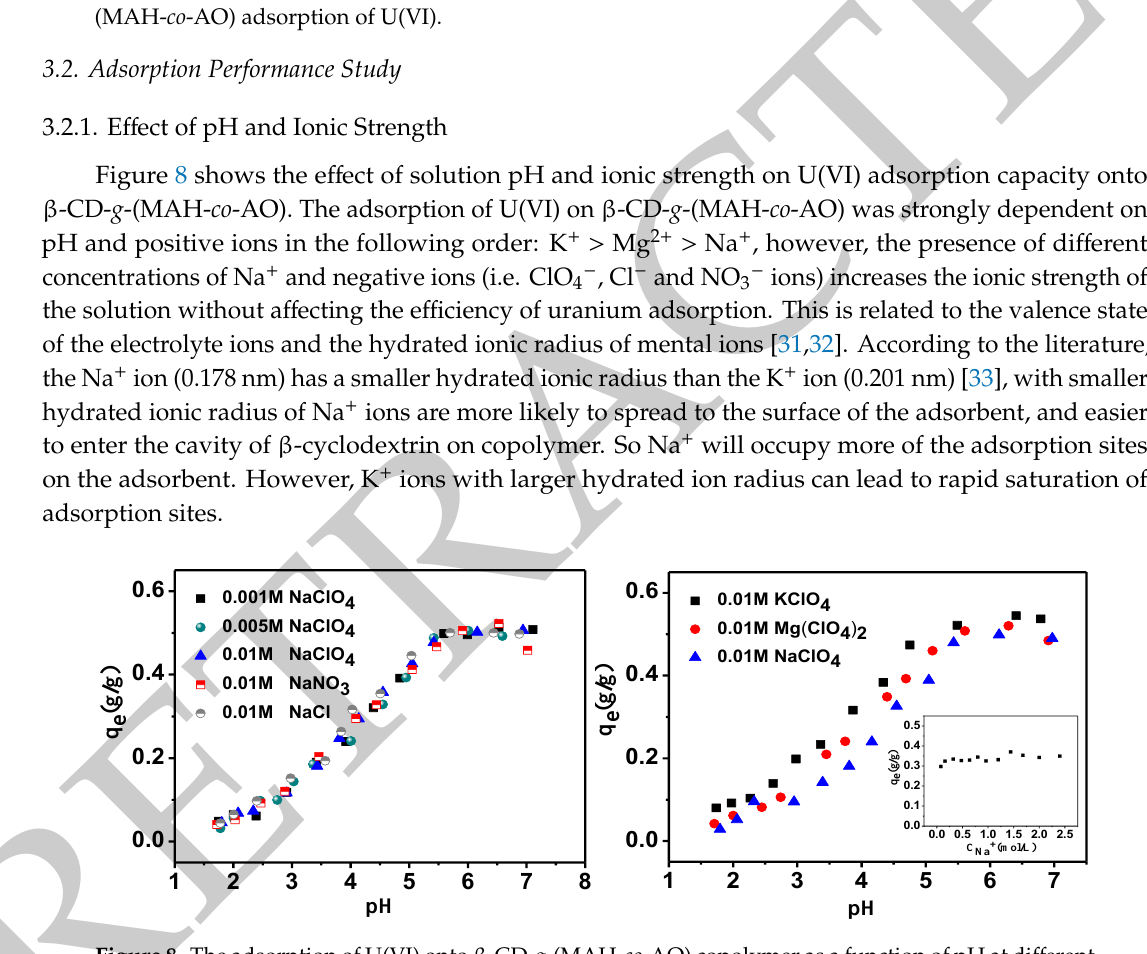
Figure 7. The TGA curves of β - CD; β -CD- g -(MAH- co - AN); β -CD- g -(MAH- co -AO); β -CD- g -(MAH- co -AO) adsorption of U(VI).